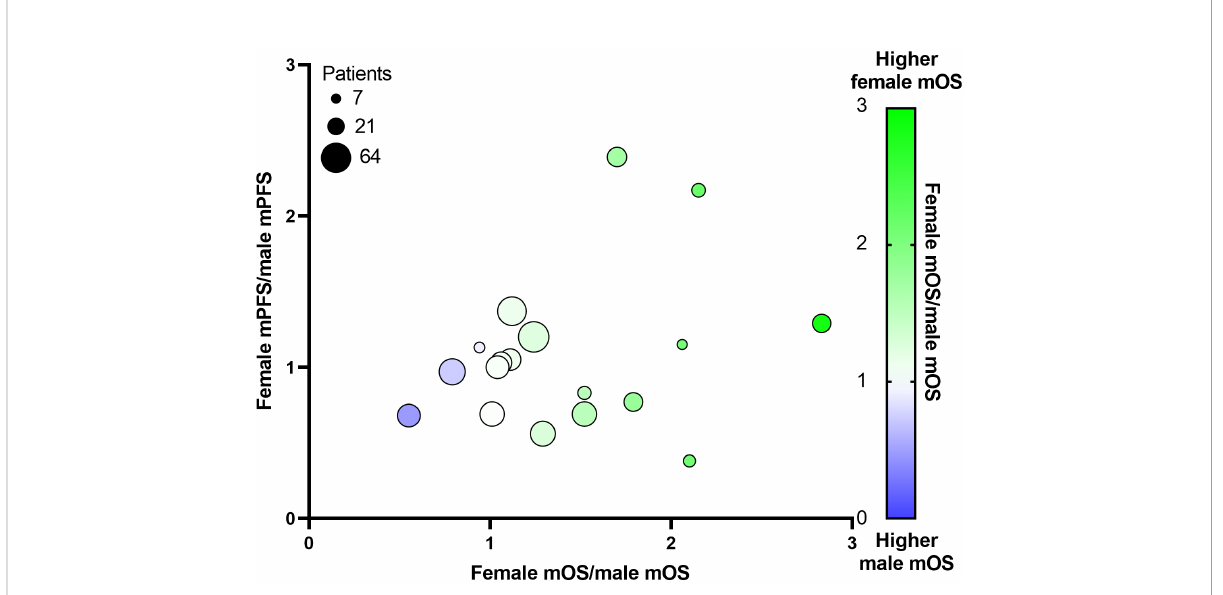
FIGURE 4 Relationship between study size, median overall survival (mOS) and median progression-free survival (mPFS) in males and female participants of treatment trials in cholangiocarcinoma. The female-to-male ratio of mOS is plotted against the female-to-male ratio of mPFS. The size of the plot is proportional to the number of participants in the treatment